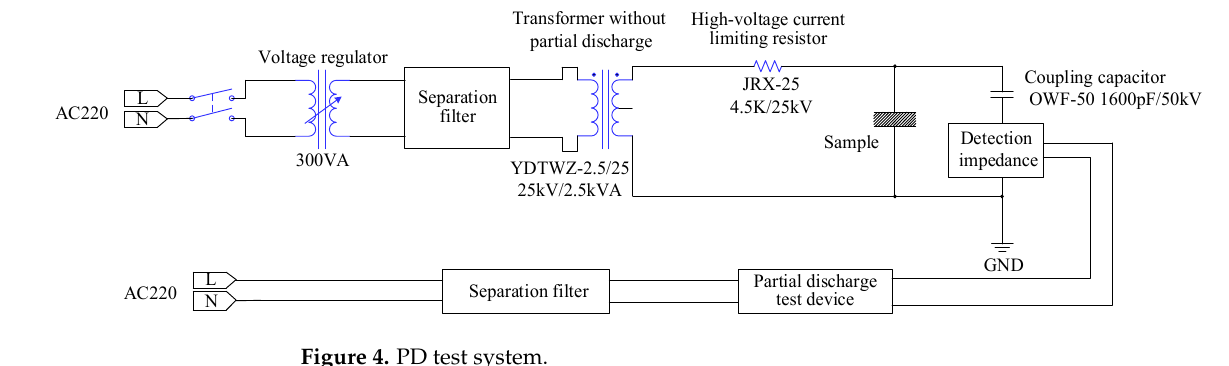
Figure 4. PD test system.